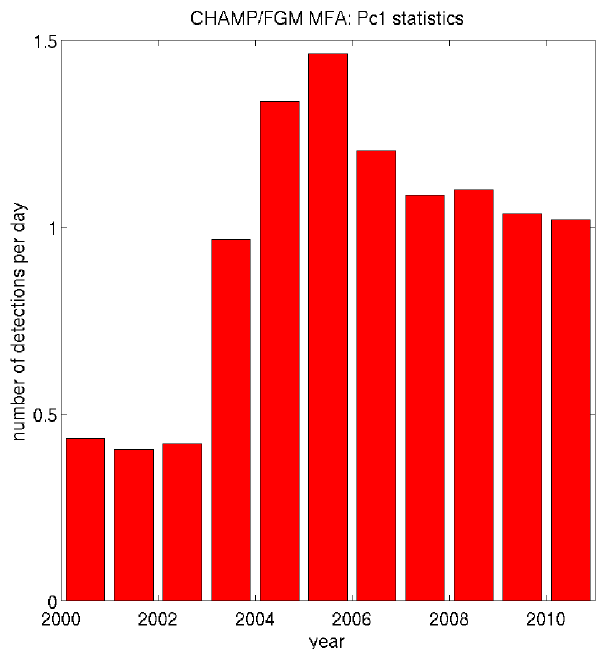
Fig. 6. Solar cycle variation of the Pc1 occurrence rate.